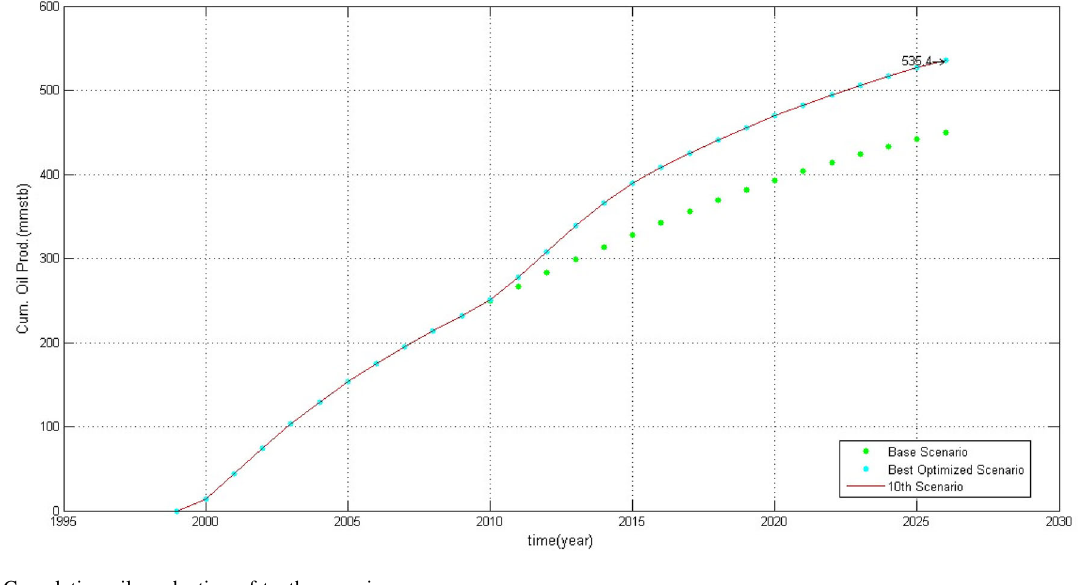
Fig. 20 Cumulative oil production of tenth scenario